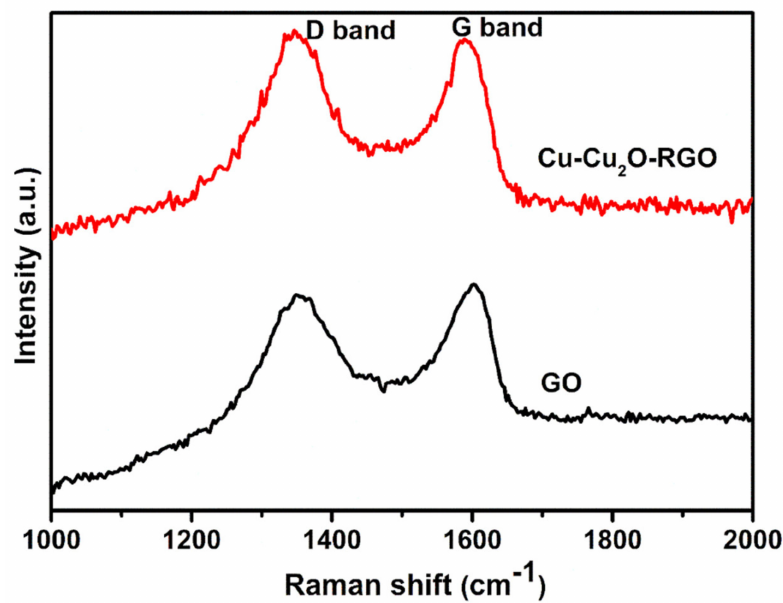
Figure 2. Raman spectra for graphite oxide ( bottom ) and the RGO/Cu/Cu 2 O composite ( top